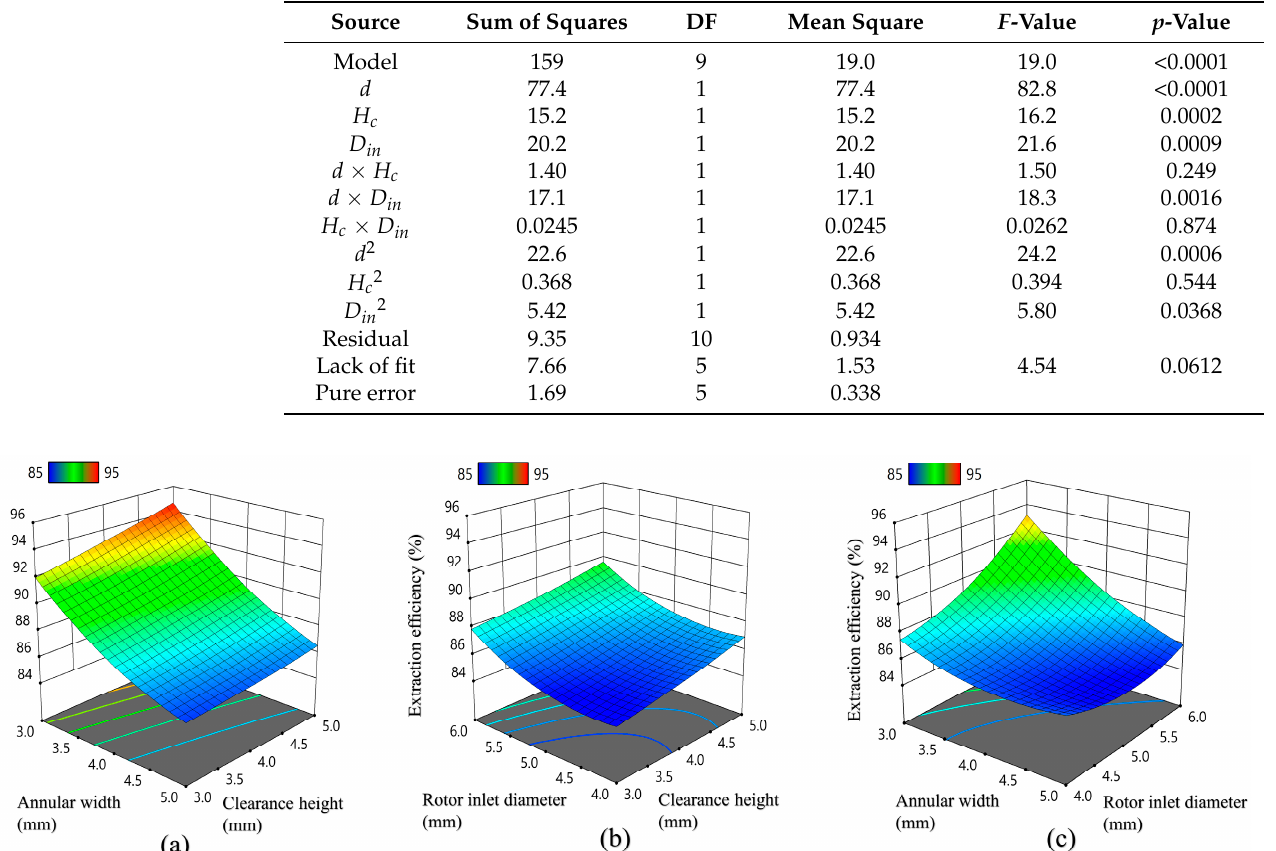
Figure 5. Variation in liquid holdup under different ( a ) annular widths with rotor inlet diameter of 6.0 mm; ( b ) clearance heights with annular width of 3.0 mm; ( c ) rotor inlet diameters with clearance height of 5.0 mm. The reason for the change in E O with the annular width can be summarized as the following two points: (1) As the annular width increased, the Vm increased. The mixing time of the annular liquid was proportional to the Vm . Therefore, the mixing time became longer, and the extractant extracted more components, which improved mass transfer per- formance. (2) The ALH decreased when the annular width increased, leading to unit vol- ume power ( P/V ) reduction. Thus, the mass transfer coefficient decreased, which was det- rimental to mass transfer. Kadam et al. [17] had given the mass transfer coefficient ( kca ) of the centrifugal ex- traction as a function of P/V , as shown in Equation (6). k c a = 0.64( P/V ) 0.22